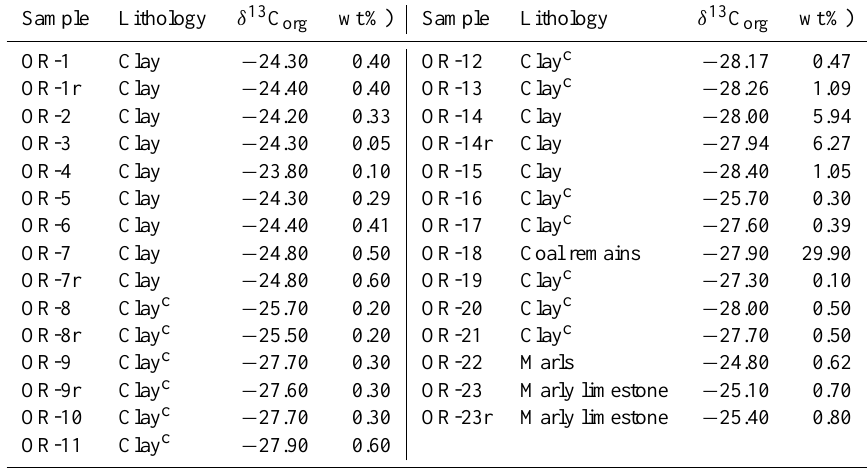
Table 1. δ 13 C org values (‰ VPDB) and organic carbon content (wt%) of the P–E interval of the Orio section.